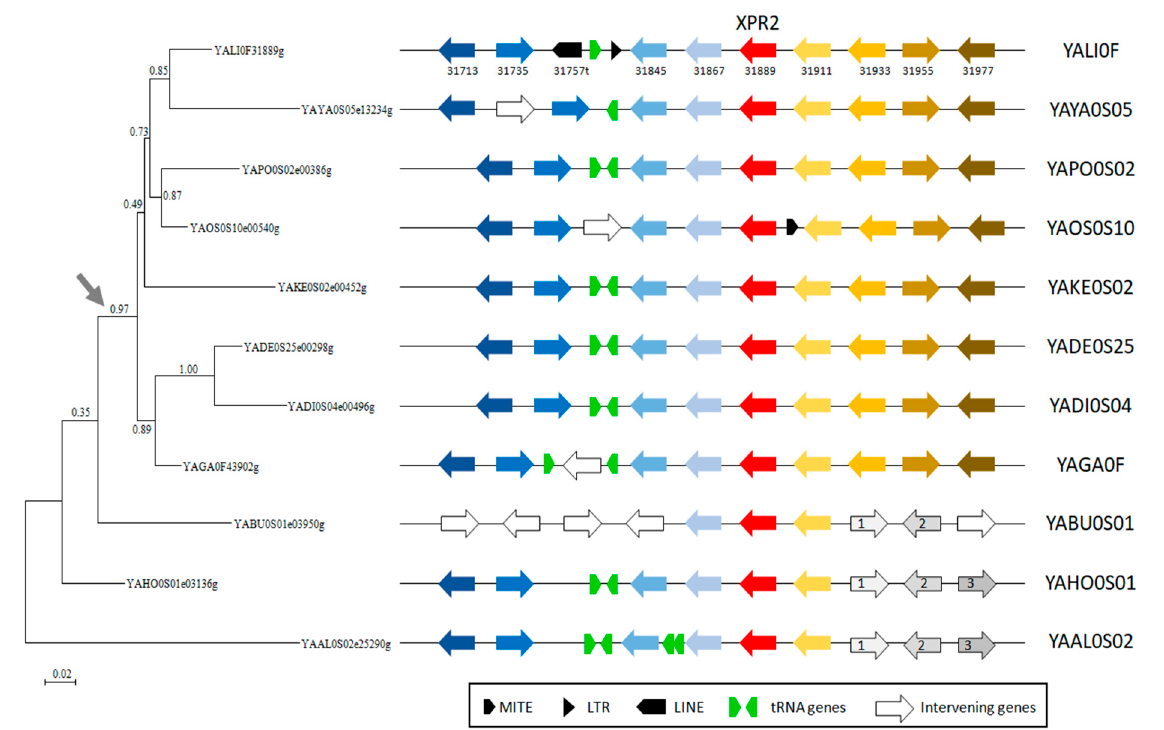
Figure 2. Synteny analysis of alkaline extracellular protease XPR2 from different Yarrowia species. The phylogenetic tree was constructed from an alignment of 446 amino acids with phyML with a LG evolutionary model. XPR2 orthologs are in red and flanking genes are in different blue or yellow to brown colors reflecting orthologs in the different species. Transposable elements (MITE, LTR, LINE) and tRNA genes are represented as described in the legend. The grey arrow close to the phylogenetic tree indicates the rearrangement event leading to the actual gene order in Y. lipolytica and closely related species.